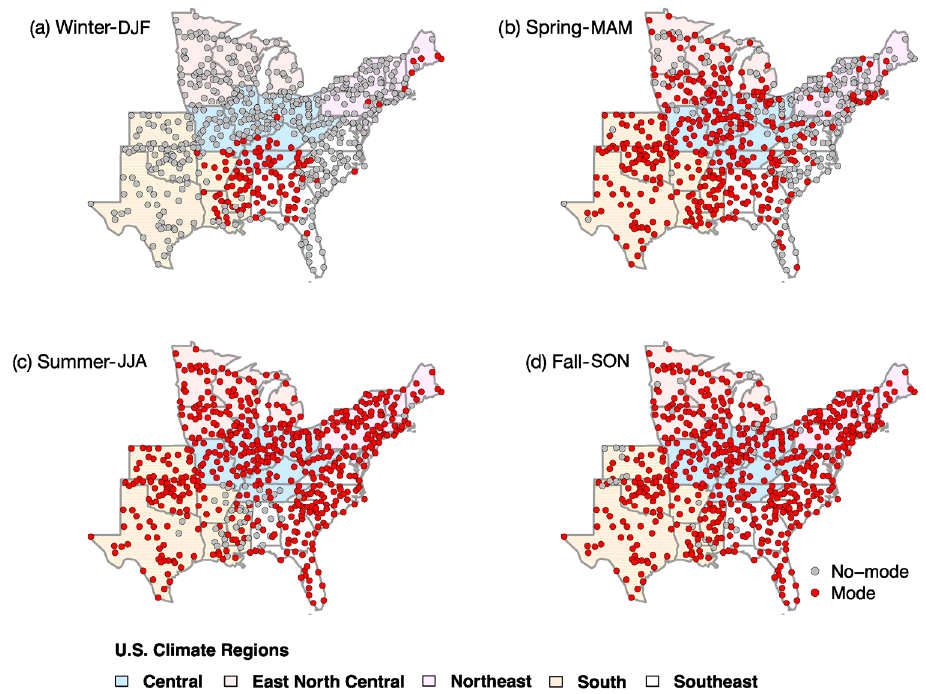
Figure 5. Seasonal significant mode of empirical probability distribution function estimates based on the calendar dates of annual maximum daily precipitation. The season is considered a significant mode when the number of significant days is at least twenty days per season.